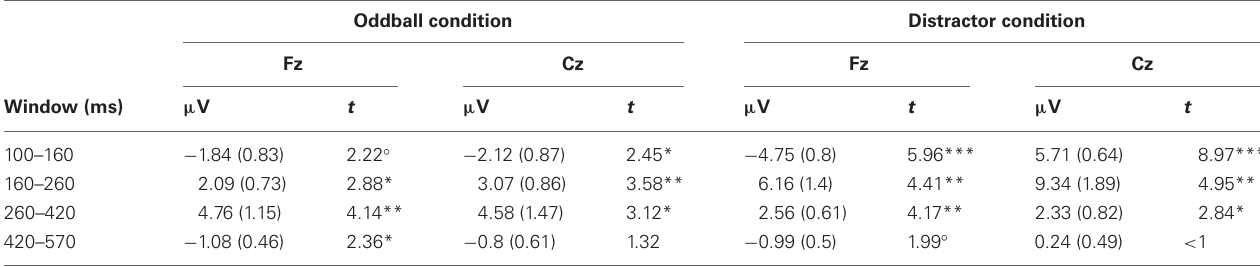
Table 3 | Mean amplitudes (and standard error of mean) and t -statistics of deviance related differences between rare and frequent trial separately for the four time windows at Fz and Cz in Experiment